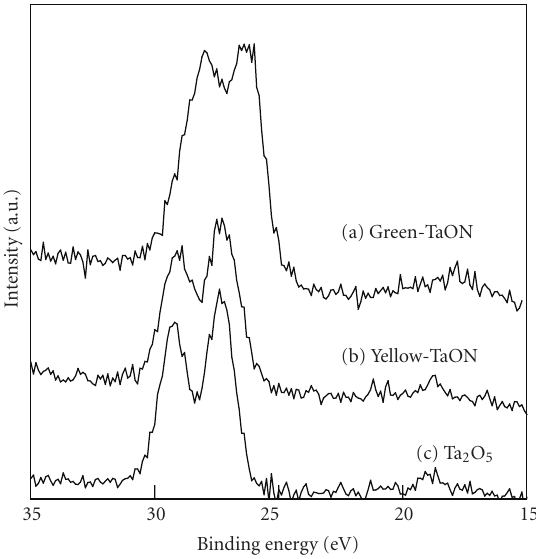
Figure 3: XPS spectra for Ta 4f in (a) green TaON synthesized via liquid-NH 3 process, (b) yellow TaON synthesized via liquid-NH 3 process, and (c) Ta 2 O 5